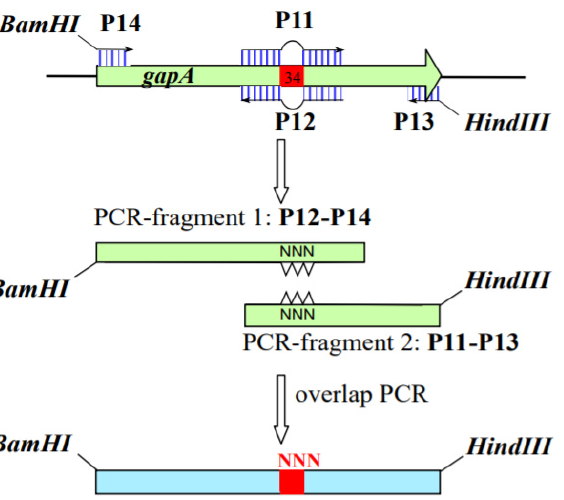
Figure 2. Scheme of construction of the mutant gapA gene with random mutation at position 34.